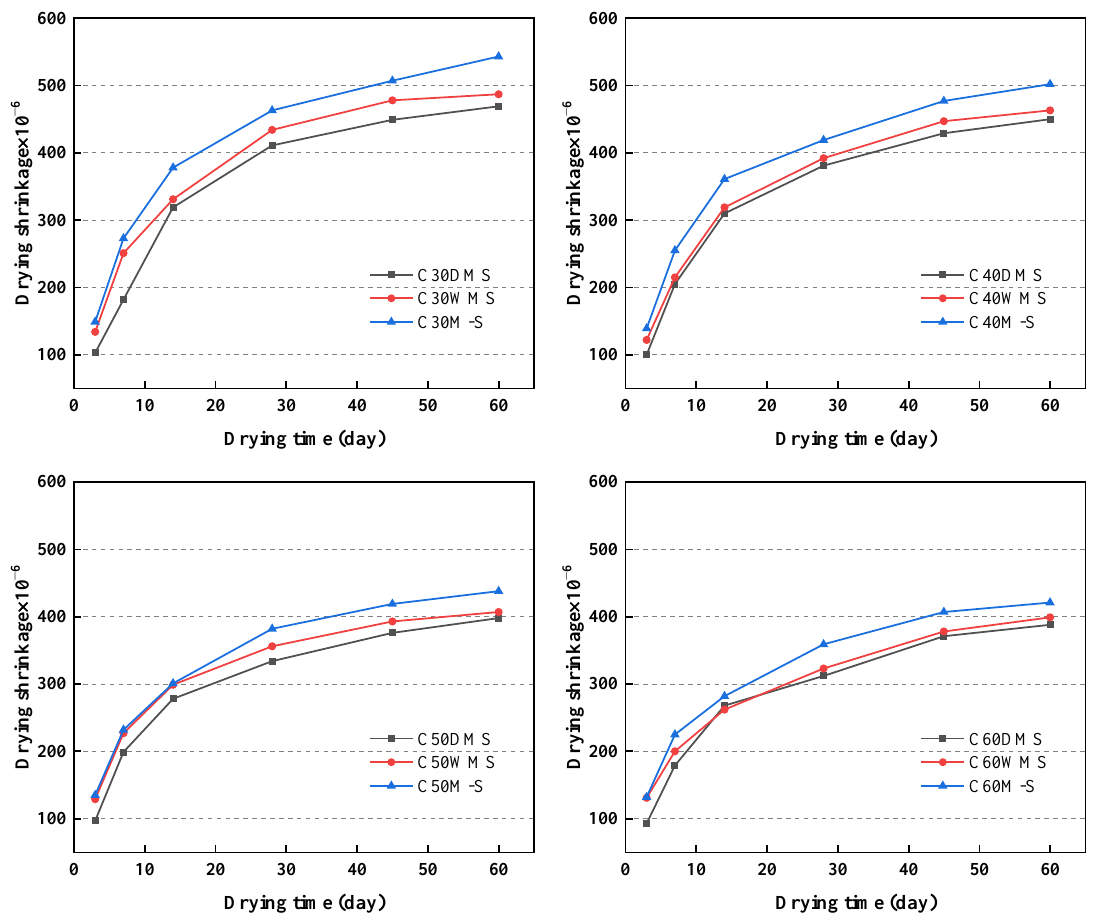
Figure 12. Drying shrinkage of concrete in each strength grade.